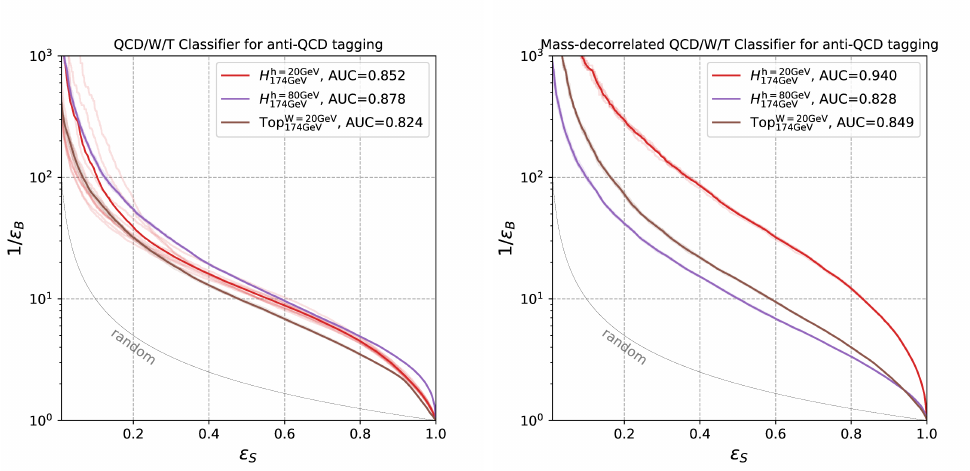
Figure 5 . OoD ROC curves for the un-decorrelated QCD/W/Top classifier ( left ) and the mass- decorrelated QCD/W/Top classifier ( right